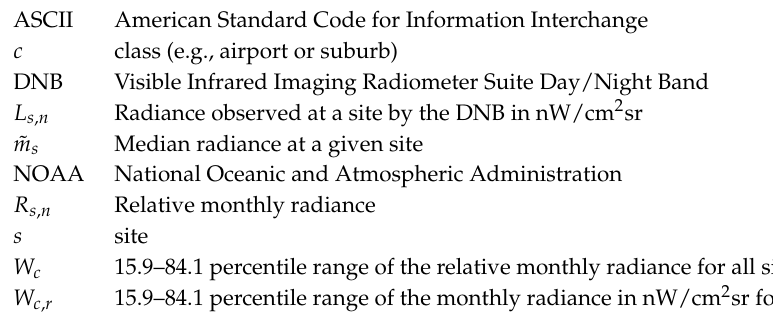
Table S1: Locations of sites used in analysis. Figure S1: Typical monthly variation in observed radiance for each class, for the three different analyses: using all months (left), using only September, October, and November (center), and using the central pixel and the four surrounding pixels (right). The variation Wc/2 is expressed as a percentage of the mean, and is roughly analogous to one standard deviation (see main text). Figure S2: Class trends in light emission from April 2012 to September 2017. For each site, the ratio of the month to the site’s median was calculated, and the mean value for a given class is plotted. Note that high latitude sites do not have data during the summer months and that the vertical scale is different for the bottom four plots. The seasonal snow cycle is clear: The brightest values are in January 2014, which was unusually cold and snowy. The bright value in the southern wilderness area in May 2016 is presumably due to a wildfire. Figure S3: Average annual trends in light emission from each class. The data are the average for each month from Figure S2. Note that northern sites do not have DNB data during the summer months, and the vertical scale is different for the bottom row of plots. The bright value in the southern wilderness areas in May is presumably due to a wildfire. Figure S4: Lighting trend for the suburban location in northern (Detroit) and southern (Jacksonville) cities, relative to the median radiance of the site. Detroit frequently has very large increases in radiance in winter months due to the presence of snow, and the brightest value was in the exceptionally cold month of January